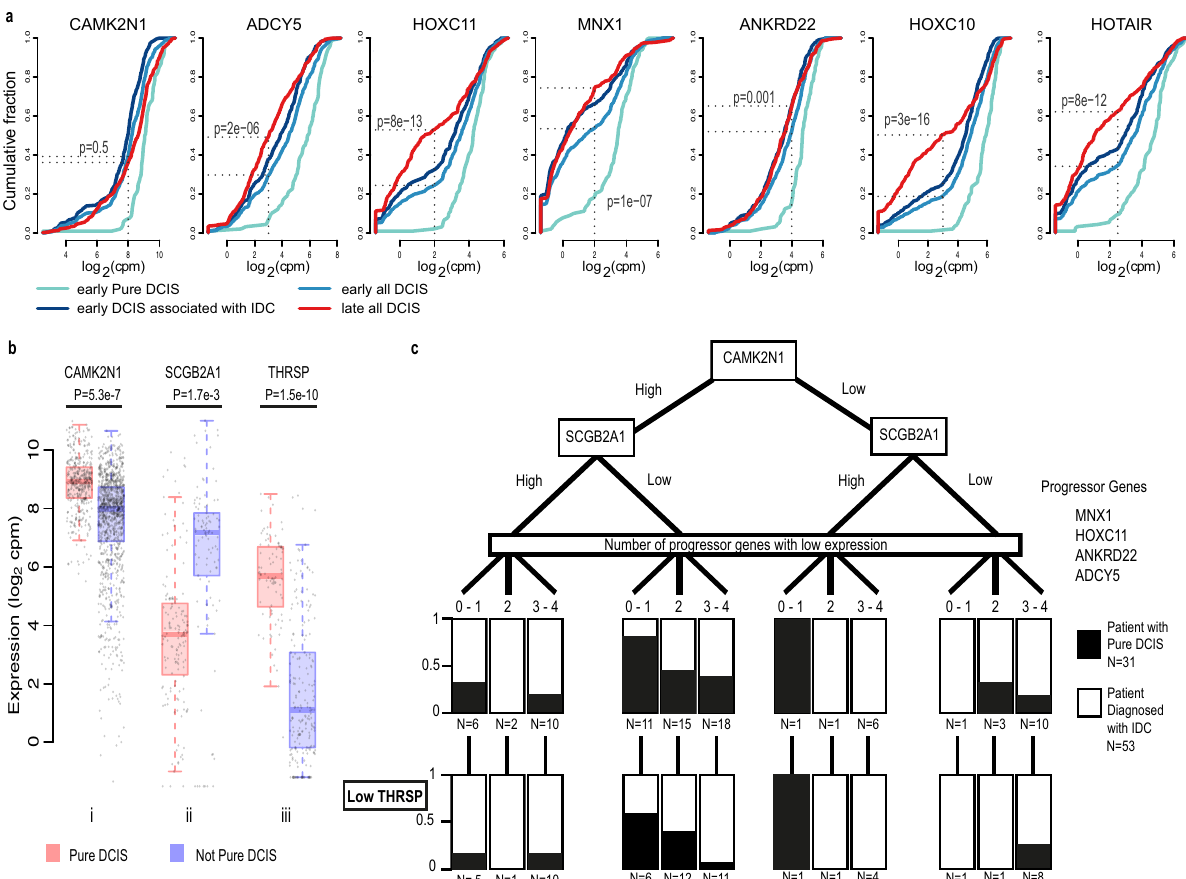
Fig. 6 Genes displaying potential as indicators of progression from DCIS to IDC. a Cumulative frequency plots for differential genes between early positioned Pure DCIS and early positioned Not Pure DCIS. X axis shows the gene expression in log 2 counts per million (CPM), Y axis shows the cumulative fraction of samples with the corresponding expression value or lower. Signi fi cance values re fl ect the two-sided Fisher ’ s exact test for a difference between cumulative fraction of all early DCIS compared to all late DCIS. b Expression in log 2 counts per million (CPM), of i CAMK2N1 for all DCIS samples (n = 385 Pure DCIS samples and n = 1014 Not Pure DCIS samples), ii of SCGB2A1 for all samples belonging to patients in the Low Hazard group – 1 progressor gene down regulated and CAMK2N1 high (n = 148 Pure DCIS samples and n = 97 Not Pure DCIS samples), and iii THRSP for all samples belonging to patients with 3 – 4 progressor genes down regulated, CAMK2N1 high and SCGB2A1 low ( n = 84 Pure DCIS samples and n = 199 Not Pure DCIS samples). Centre line represents the median, box limits represent upper and lower quartiles, whiskers represent minimum and maximum values and at most 1.5x the interquartile range. Each point represents a sample. Differential expression analysis was done using limma-voom and two-sided p -values were adjusted for multiple testing using Benjamini – Hochberg correction. c Separation of patients with no IDC identi fi ed in our tissue biopsy. In all, 31 patients were never diagnosed with IDC after 10 + years of care, 53 patients were diagnosed with IDC in a secondary biopsy or at a later timepoint. Black/white regions re fl ect the proportion of patients with each diagnosis (Pure DCIS vs with IDC) within each node. Boxes in the low THRSP layer re fl ect the number of THRSP low patients from the node